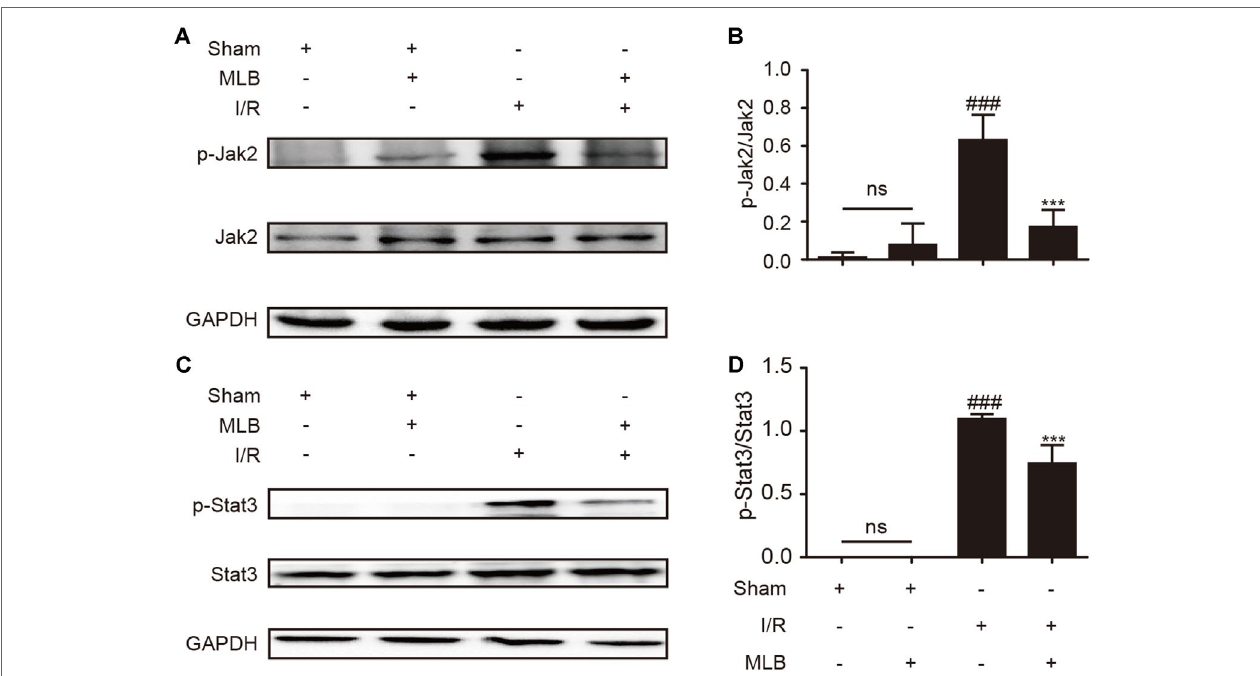
FIGURE 4 | MLB pretreatment inhibited Jak2/Stat3 signal pathway in the liver tissue of I/R. (A) Western blot was utilized to detect the level of p-Jak2. (B) The quantification of p-Jak2/Jak2 was statistically analyzed. (C) Western blot was utilized to detect the level of p-Stat3. (D) The quantification of p-Stat3/Stat3 was statistically analyzed. The data are expressed as mean ± SD; n = 5 for each group; ns: no statistical significance; ### P < 0.001 versus sham group; ***P < 0.001 versus I/R group.